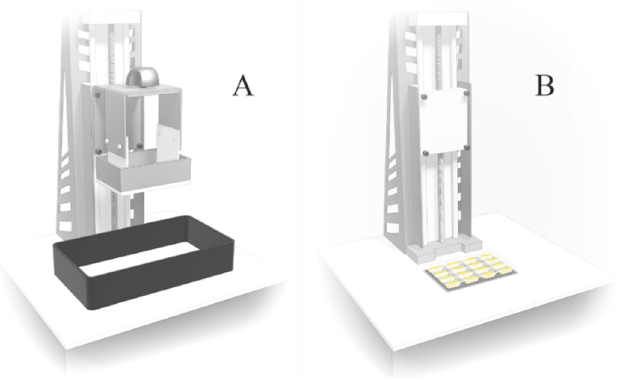
Figure 1. 3 D printer structure: ( A )—original; ( B )—adapted to cure resin in blisters. Figure 1. 3D printer structure: ( A )—original; ( B )—adapted to cure resin in